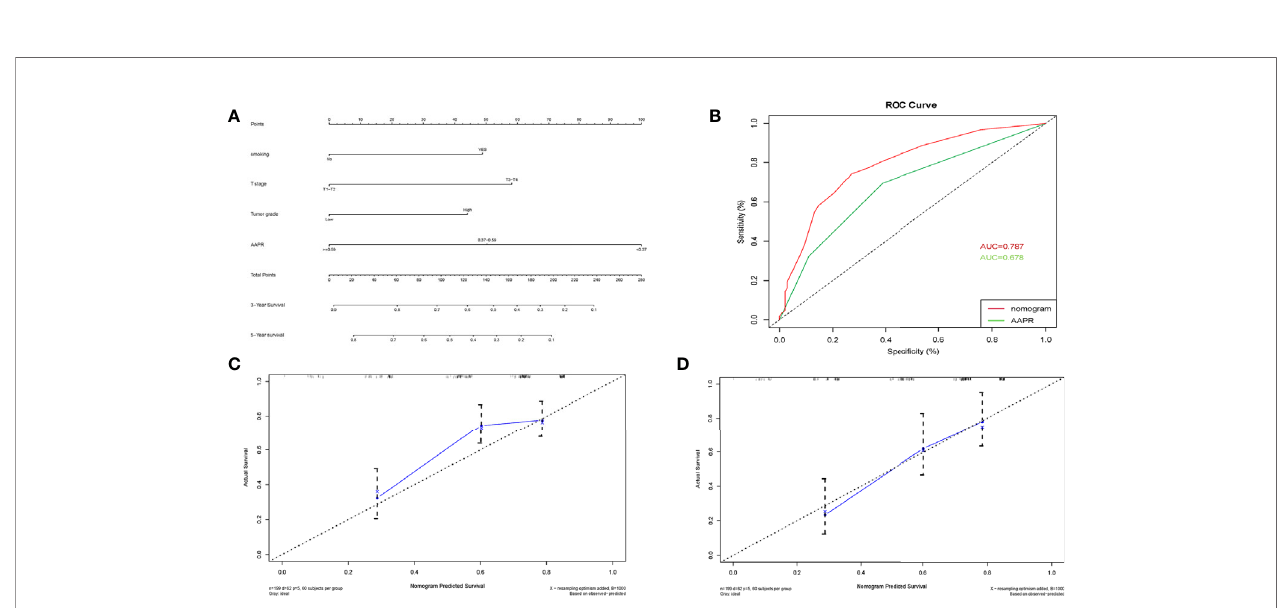
FIGURE 6 | Nomogram model constructed by independent prognostic factors predicting 3- and 5-year OS for BC patients treated with RC (A) ; the ROC curve of AAPR and AAPR-based nomogram for predicting OS in the primary cohort (B) ; corresponding calibration curves of nomogram model for 3- and 5- year OS (C, D) . OS, overall survival; AAPR, albumin-to-alkaline phosphatase ratio; BC, bladder cancer; ROC, receiver operating characteristic; AUC, area under curve; CI, con fi dence